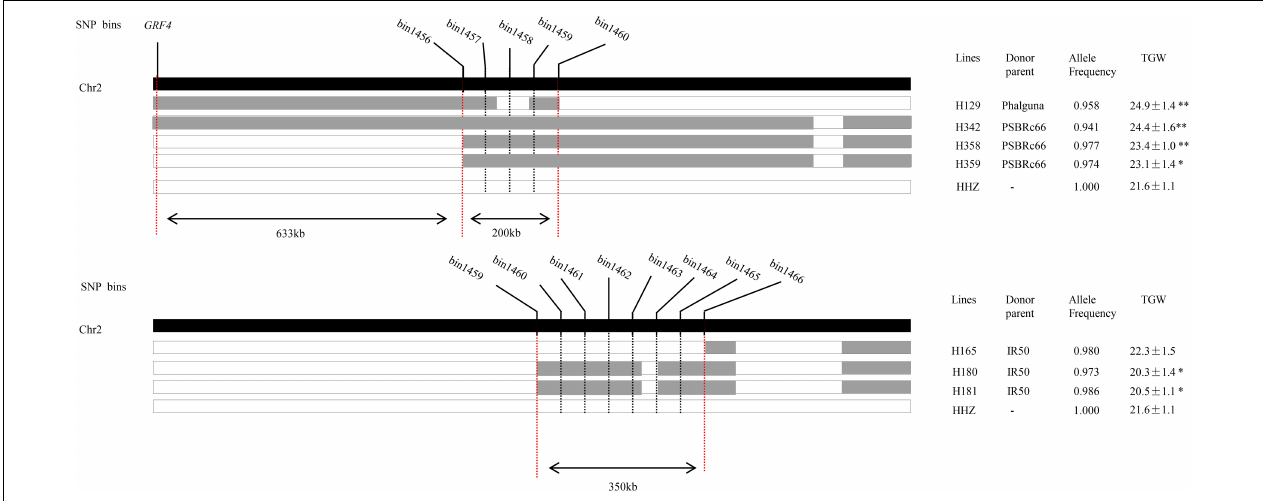
FIGURE 2 | The physical location of qTGW2-1 delimited by graphical genotype mapping. The black-colored strip indicates chromosome 2. The gray and white strips show the homozygous introgressed segment derived from the donor and HHZ, respectively. The allele frequency is the percentage of the alleles of HHZ. * and ** represent significant differences at P ≤ 0.05 and 0.01,